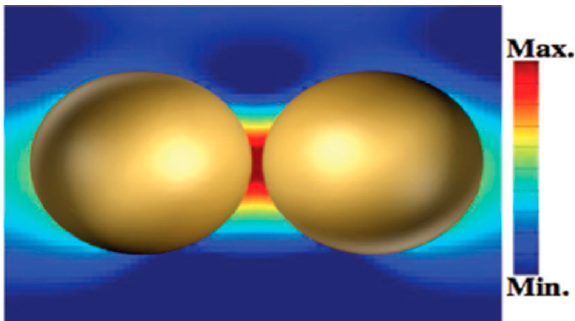
Figure 1. Representative electric field distribution of surface-enhanced Raman scattering (SERS)-active Au nanoparticles (NPs) at a “hotspot” site. (Reprinted with permission from Wiley, 2018 [11]).